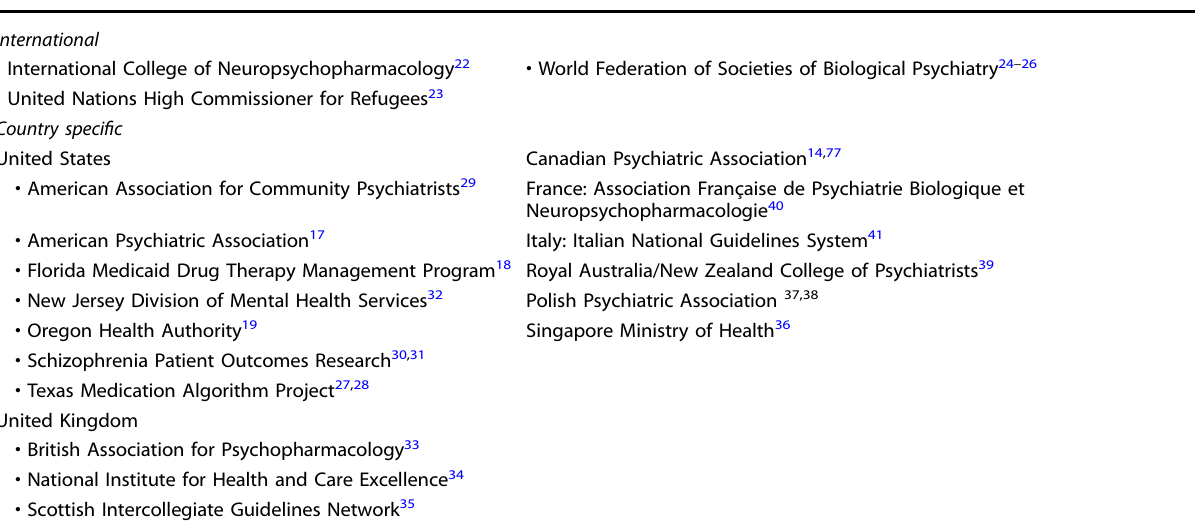
Table 1. Guidelines included in the